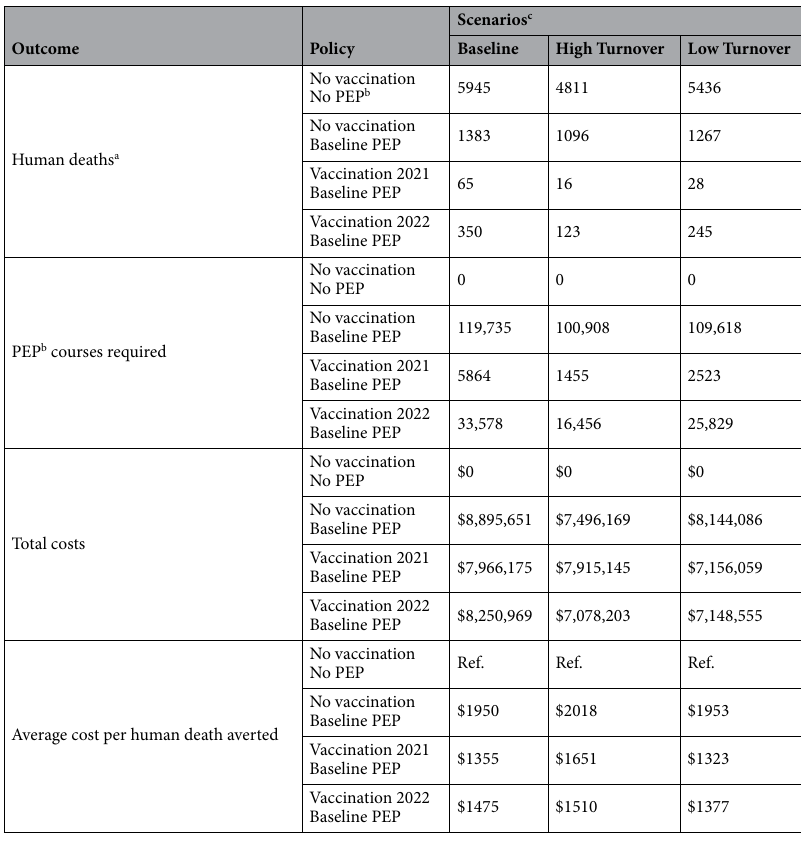
Table 3. Sensitivity analysis: 5-year health and cost effectiveness outcomes for different scenarios of dog turnover and dog-to-dog rabies infectiousness. a Total human rabies deaths; we assume only 10% of these would be reported. b PEP = post-exposure prophylaxis. The baseline PEP assumption is that 80%